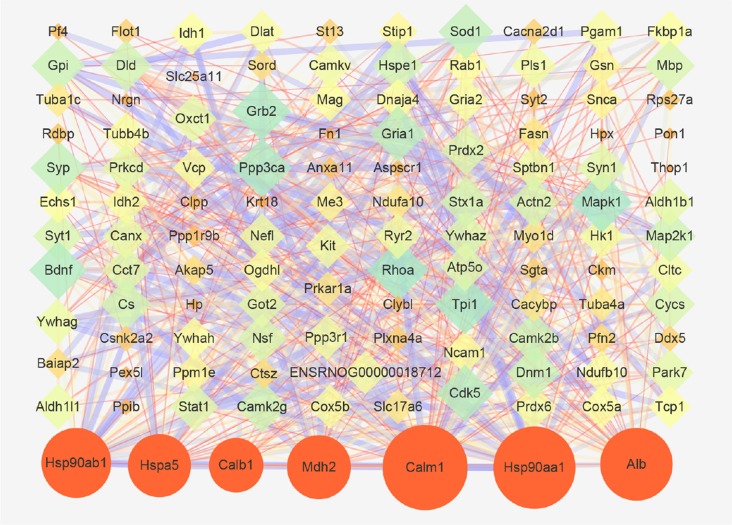
Protein-protein interaction (PPI) network of proteins that are differentially expressed in acute IS. The network was generated using the STRING database. There was an interaction network of DEP members. Six key proteins with a high degree are indicated by orange circles. Nodes represent the proteins, with the node size proportional to the interaction amount. Edges share PPIs, with the edge size proportional to the relationship.